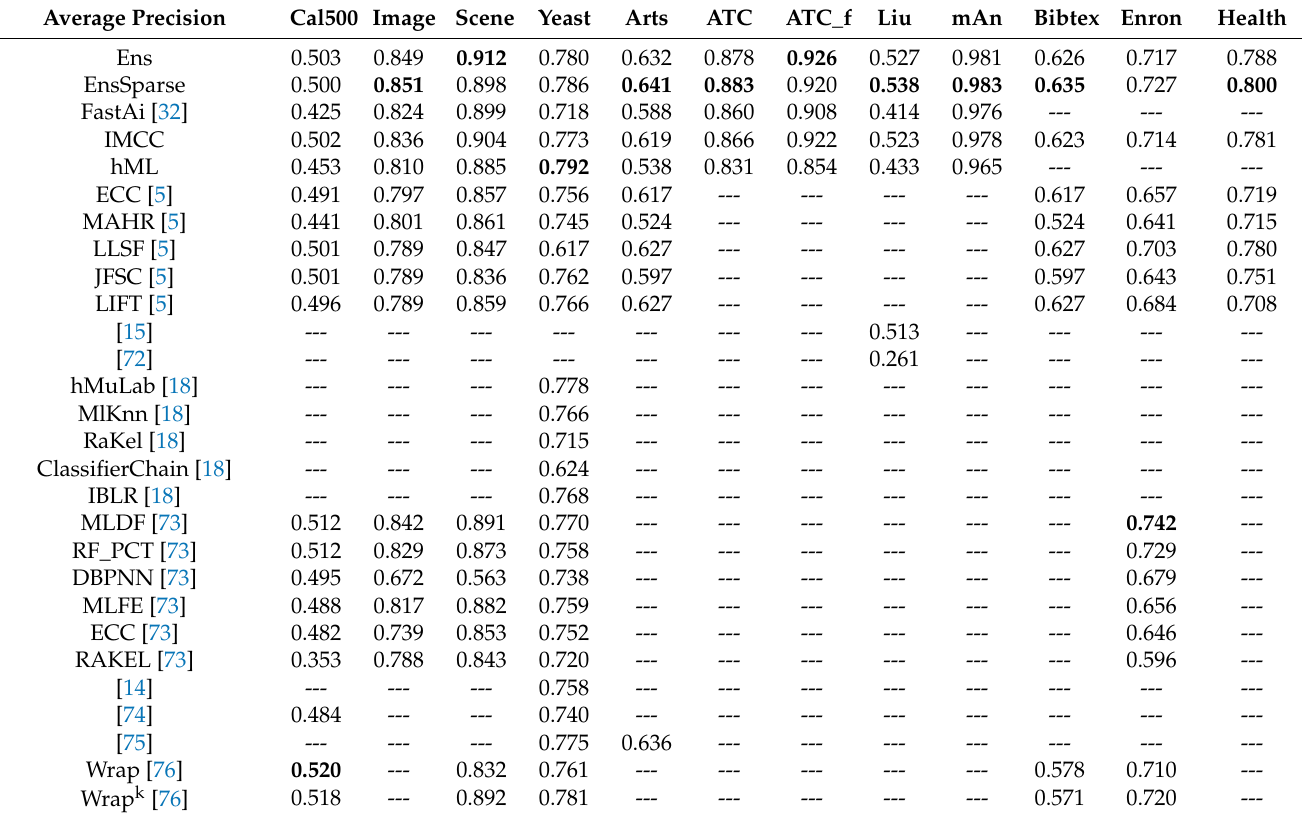
Table 9. Other comparisons with the literature using average precision. Bold highlights superior